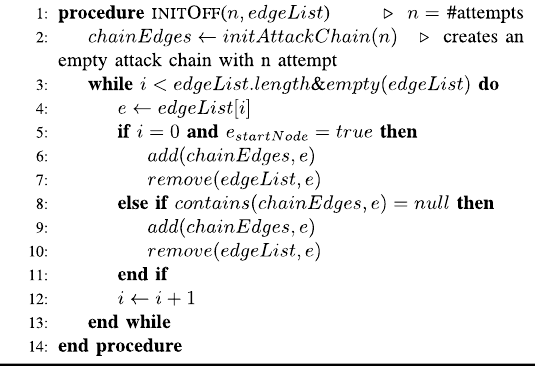
Figure 2. Pseudocode for Initialize Offense